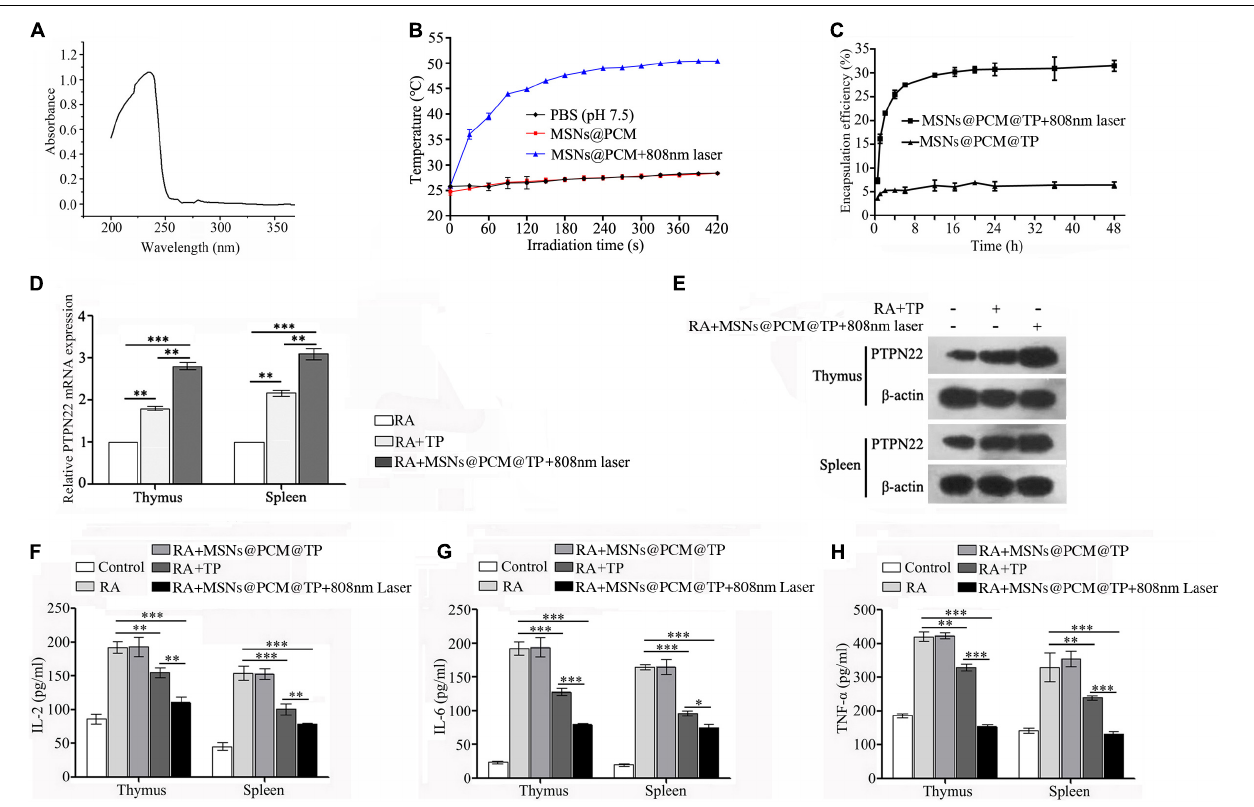
FIGURE 7 | MSNs@PCM@TP downregulated the activation of the immune system in the RA rat model. (A) The maximum absorption peak of TP in PBS (pH 7.4) was found by full wavelength scanning. (B) The temperature changing of MSNs@PCM under 808 nm laser. (C) Encapsulation efficiency profiles of the MSNs@PCM@TP for TP were determined by use of semipermeable dialysis bags in PBS (pH 7.4) at 37 ◦ C. (D,E) mRNA and protein expression of PTPN22 in the thymus and spleen of RA rat treated with 100 µ g/ml MSNs@PCM@TP under 808 nm laser irradiation for 1 week as detected by qPCR and Western blot assay, respectively. (F–H) Serum levels of IL-2, IL-6, and TNF- α in rats treated with 100 µ g/ml MSNs@PCM@TP under 808 nm laser irradiation for 1 week, as determined by ELISA. Experiments were repeated three independent times ( ∗ p < 0.05, ∗∗ p < 0.01, and ∗∗∗ p <